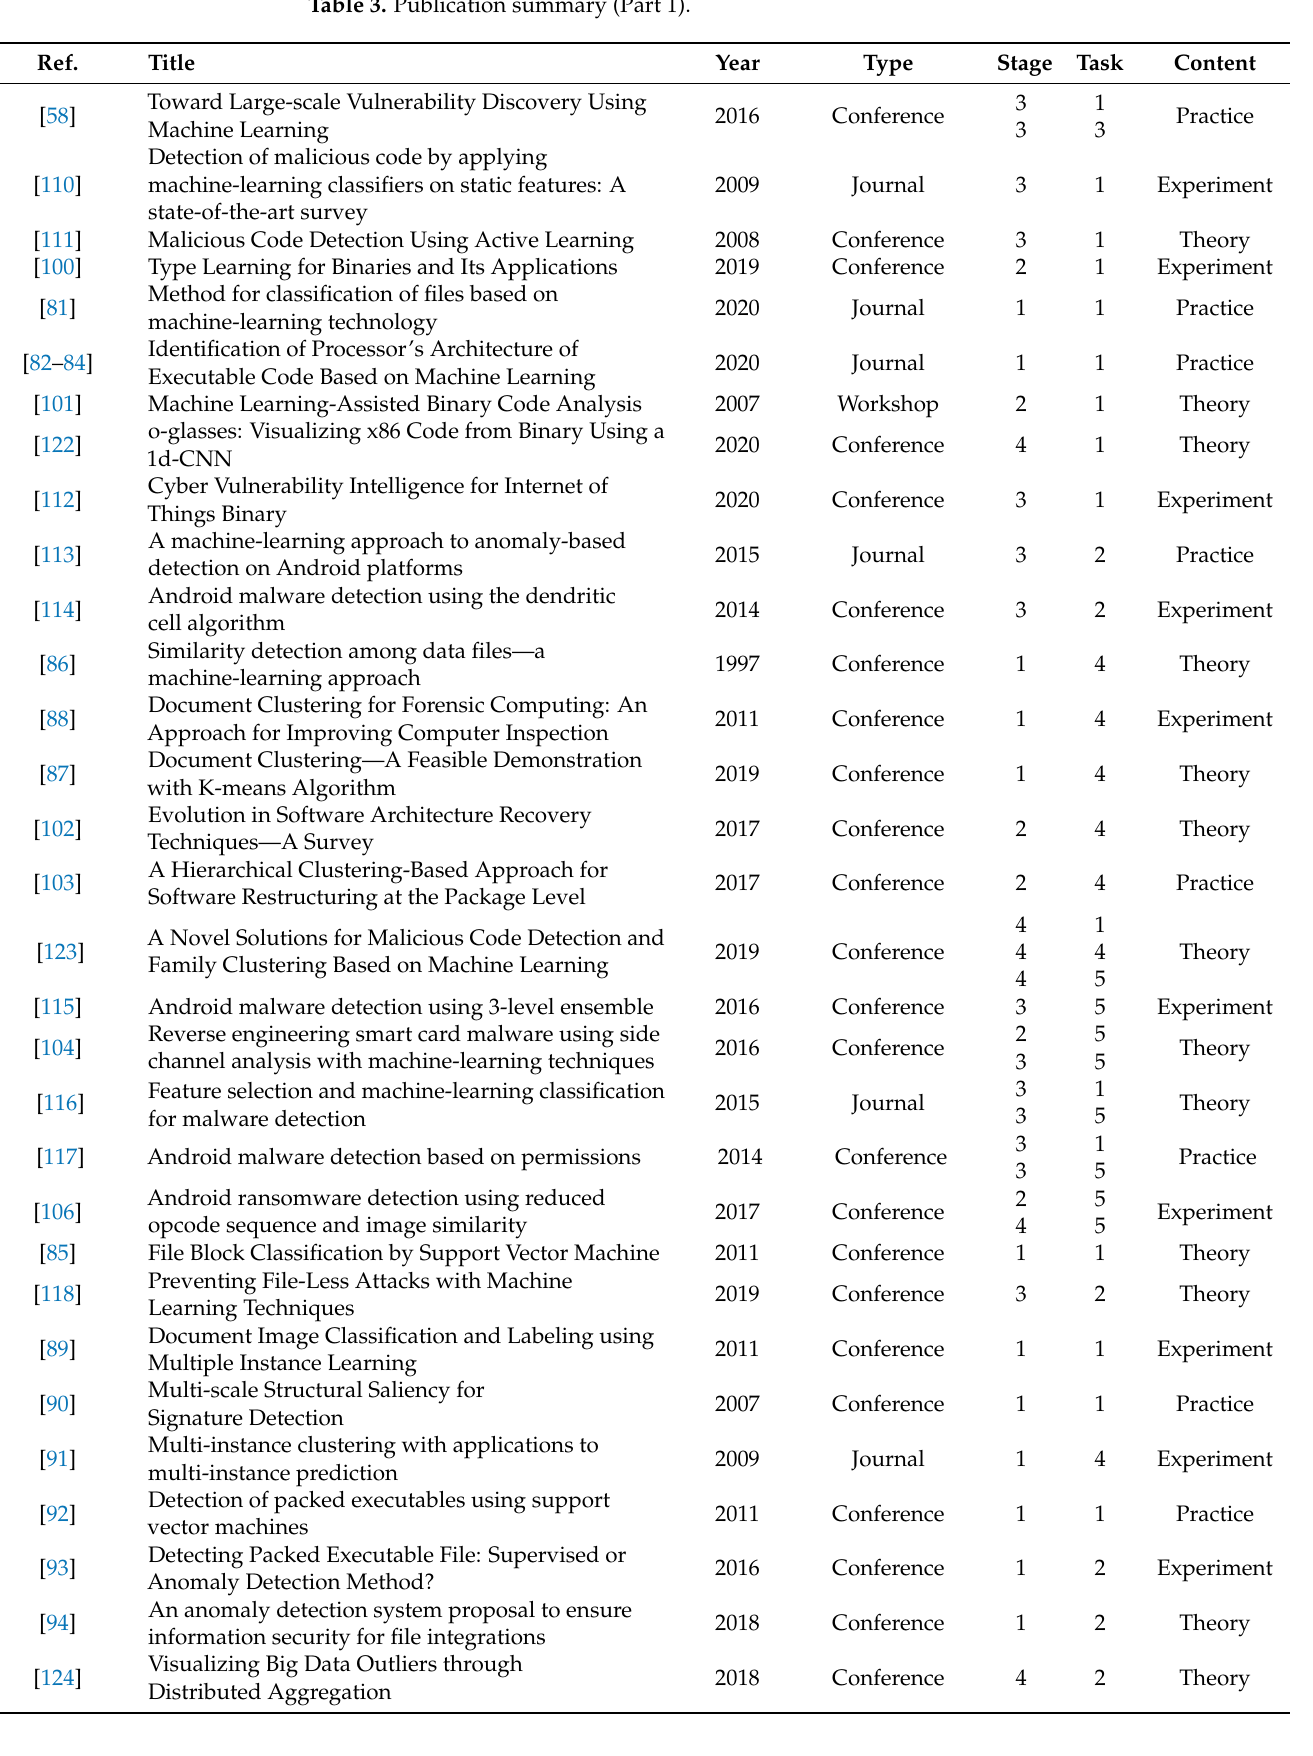
Table 3. Publication summary (Part 1).